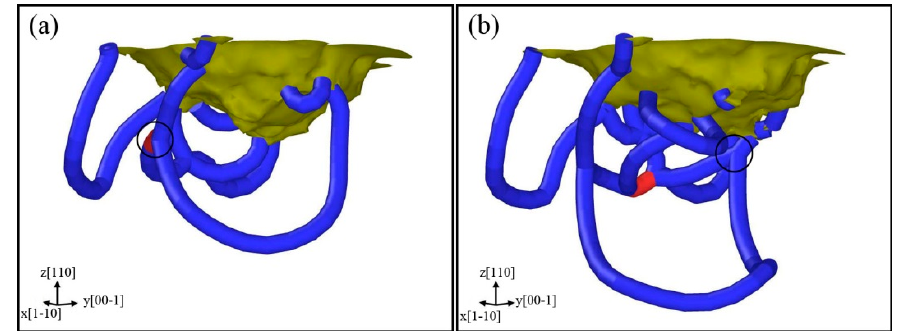
Figure 13. Dislocation structures analyzed with the dislocation extraction algorithm (DXA), where ( a , b ) are corresponding to Figure 12b,c, with black circles representing portions where two loops intersect with each other.